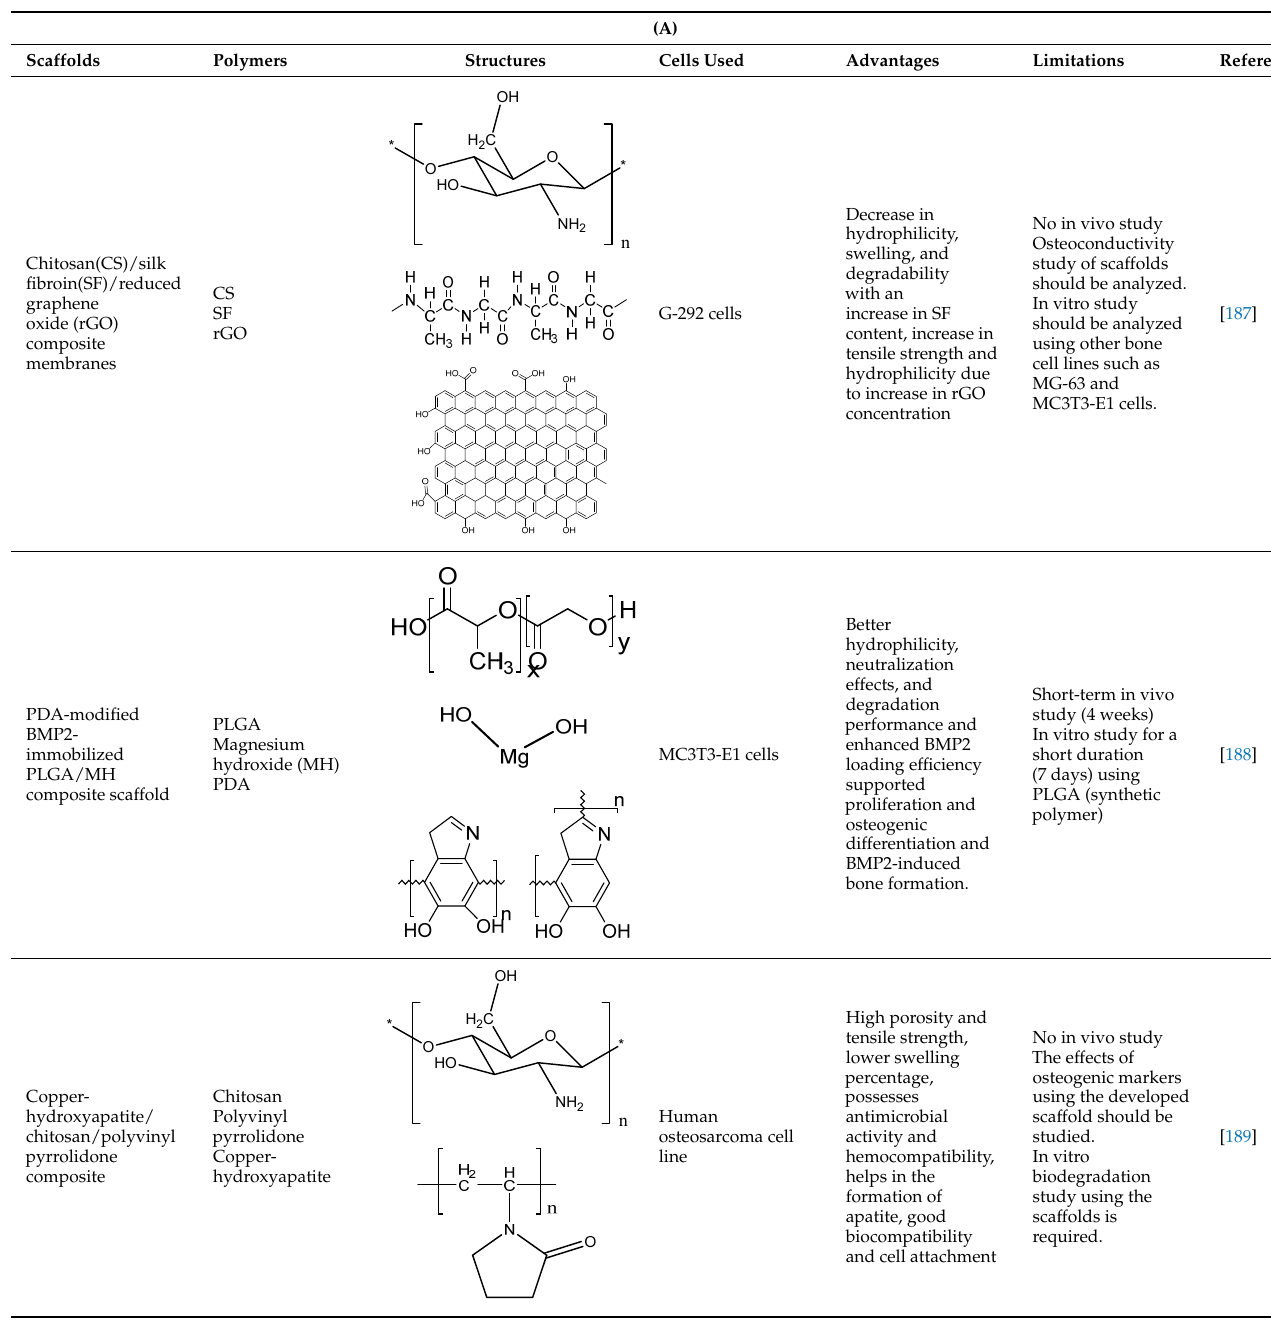
Table 1. Lists of fabricated scaffolds used in bone tissue engineering, polymers, and their structures, cells used, advantages, and limitations. ( A ) Solvent casting. ( B ) Freeze drying. ( C ) Gas foaming. ( D ) Phase separation method. ( E ) Hydrogels. ( F ) Microspheres. ( G ) Electrospinning. ( H ) Additive manufacturing